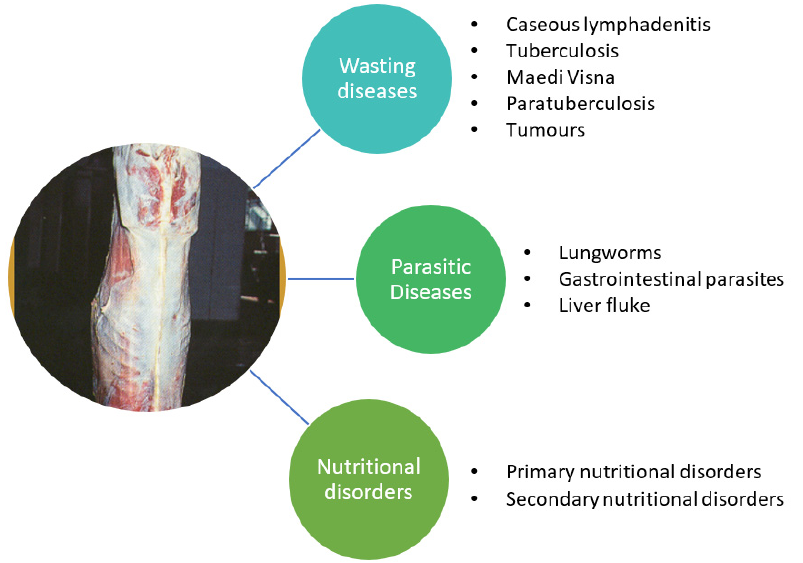
Figure 2. Categorization of the main non-scrapie diseases or conditions associated with a chronic wasting syndrome in small ruminants.